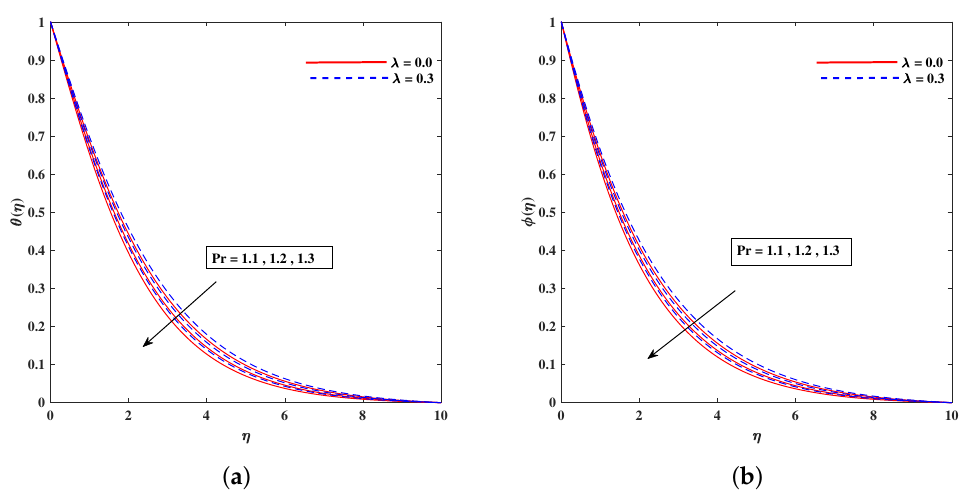
Figure 8. Fluctuation of Pr on temperature θ ( η ) ( a ) and concentration profile φ ( η ) ( b ).